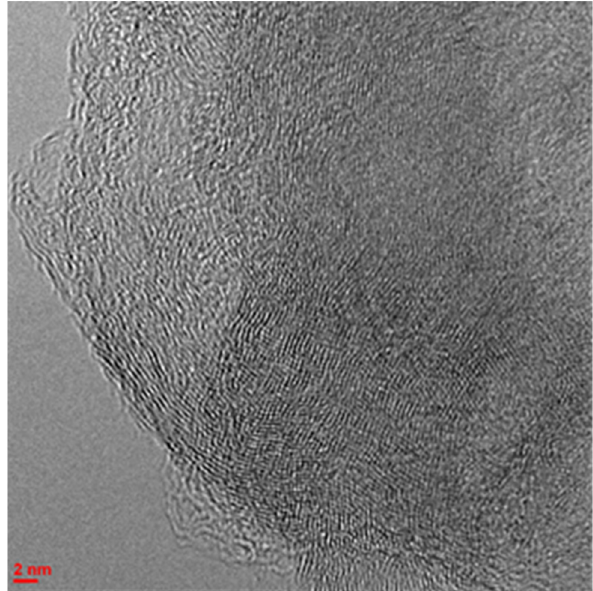
Figure 1. Micrograph of the surface of the catalyst 0.1Pt/C ox .